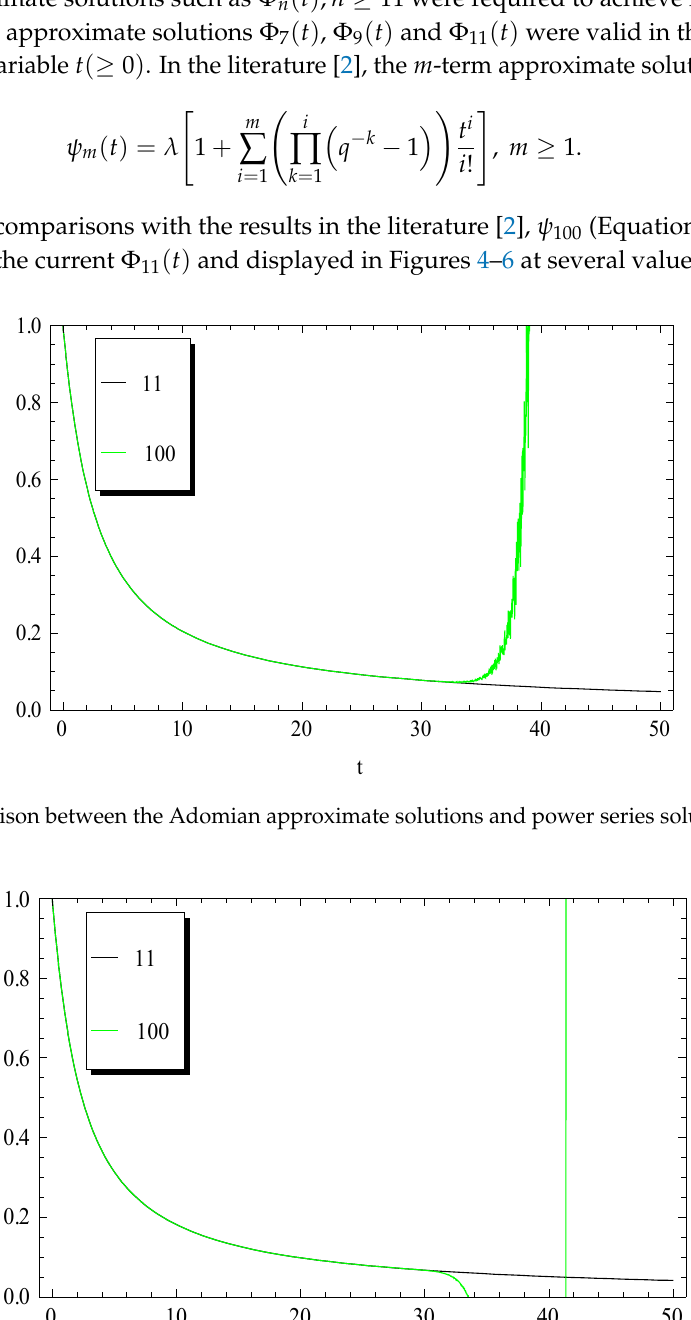
Figure 6. Comparison between the Adomian approximate solutions and power series solution at 1 =λ and 2 = q .